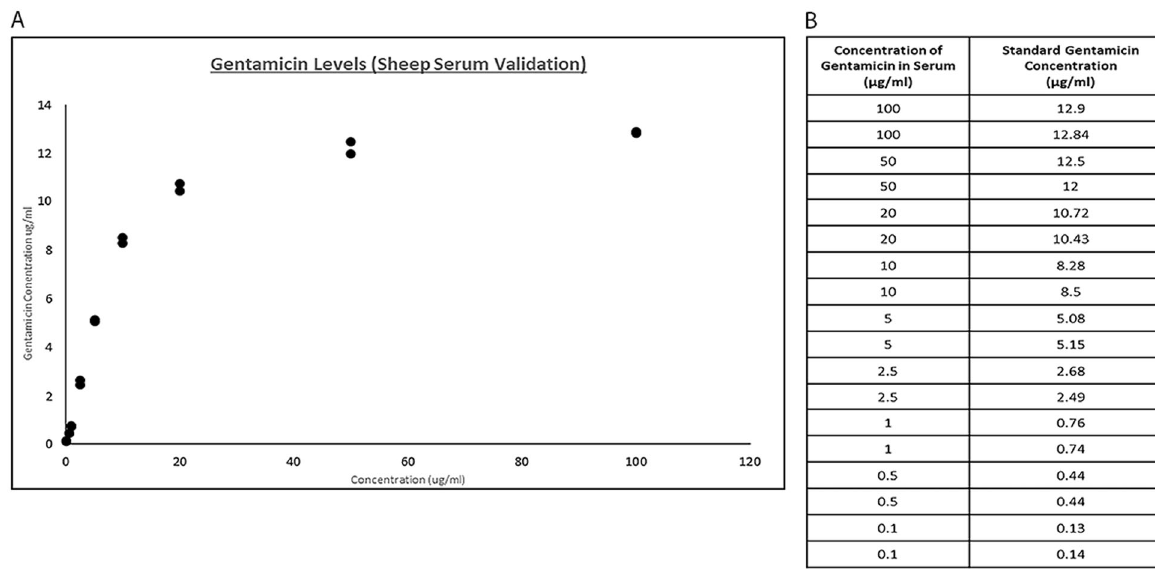
Fig. 1 a , b Sheep serum validation with known concentrations of gentamicin. Dose response curve ( a ) and data ( b ) obtained for known gentamicin levels in sheep serum. Gentamicin concentrations of 0.1, 0.5, 1, 2.5, 5, 10, 20, 50 and 100 µg/ml were prepared to provide a standard